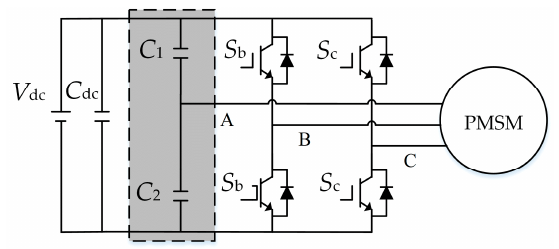
Figure 1. TPFS inverter-fed PMSM drive system topology.